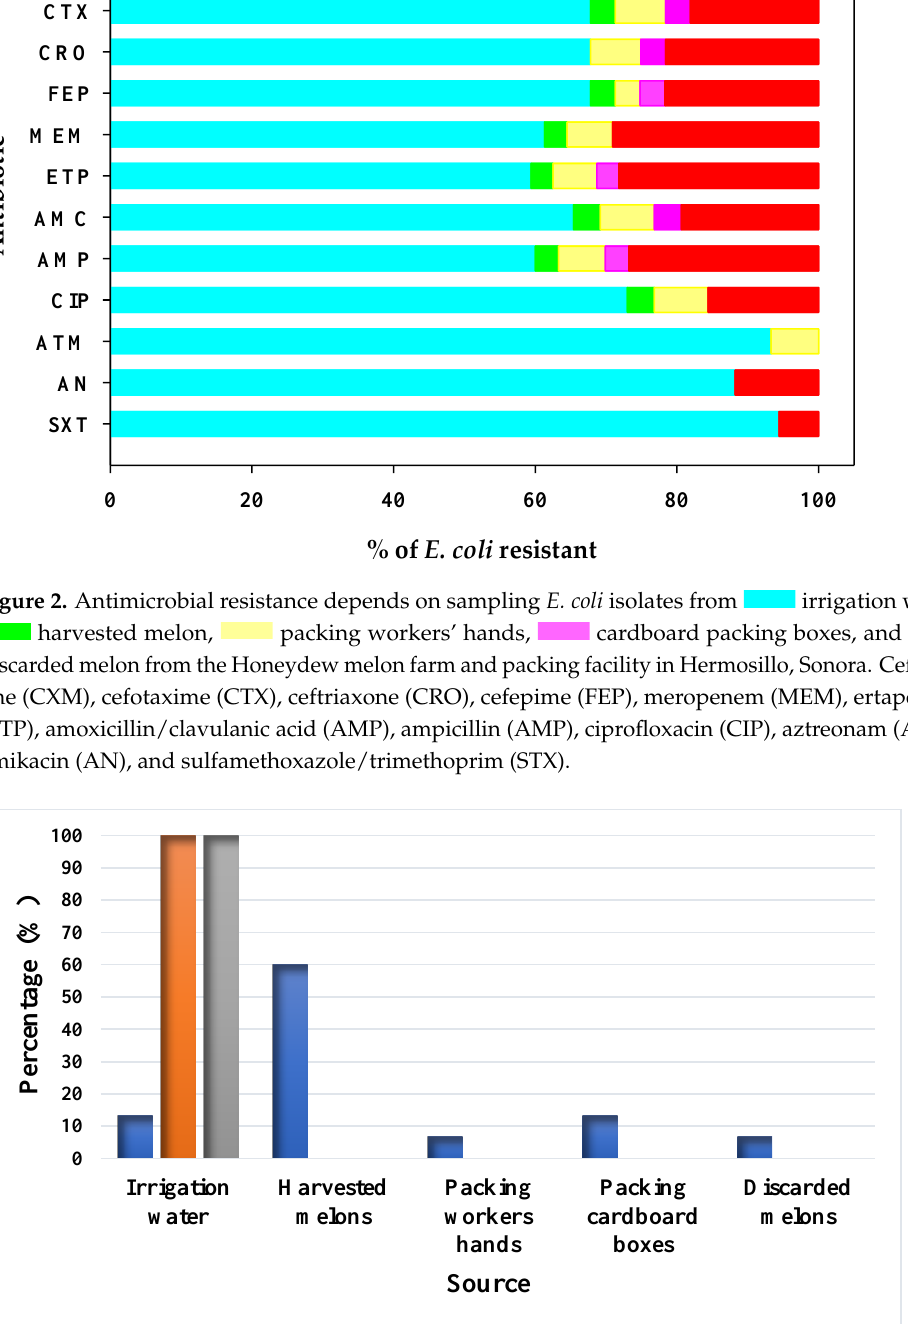
5 of 15 Figure 1. Susceptibility and resistance profile of E. coli strains isolated from the farm and packing facilities from Honeydew melon in Hermosillo, Sonora. Cefuroxime (CXM), cefotaxime (CTX), ceftriaxone (CRO), cefepime (FEP), meropenem (MEM), ertapenem (ETP), amoxicillin/clavulanic acid (AMC), ampicillin (AMP), ciprofloxacin (CIP), aztreonam (ATM), amikacin (AN), and sulfa- methoxazole/trimethoprim (STX). This study showed that irrigation water had the highest prevalence of multidrug- resistant E. coli strains, followed by discarded melons, cardboard packaging boxes, har- vested melons, and workers ’ hands (Figure 2). The antibiotic-resistant profiles of E. coli